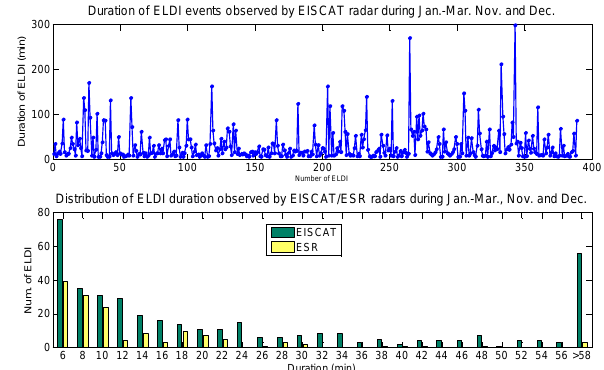
Figure 4. Variation of ELDI duration inferred from EISCAT radar measurements (the upper panel) and distribution from both radars (the bottom panel). 492